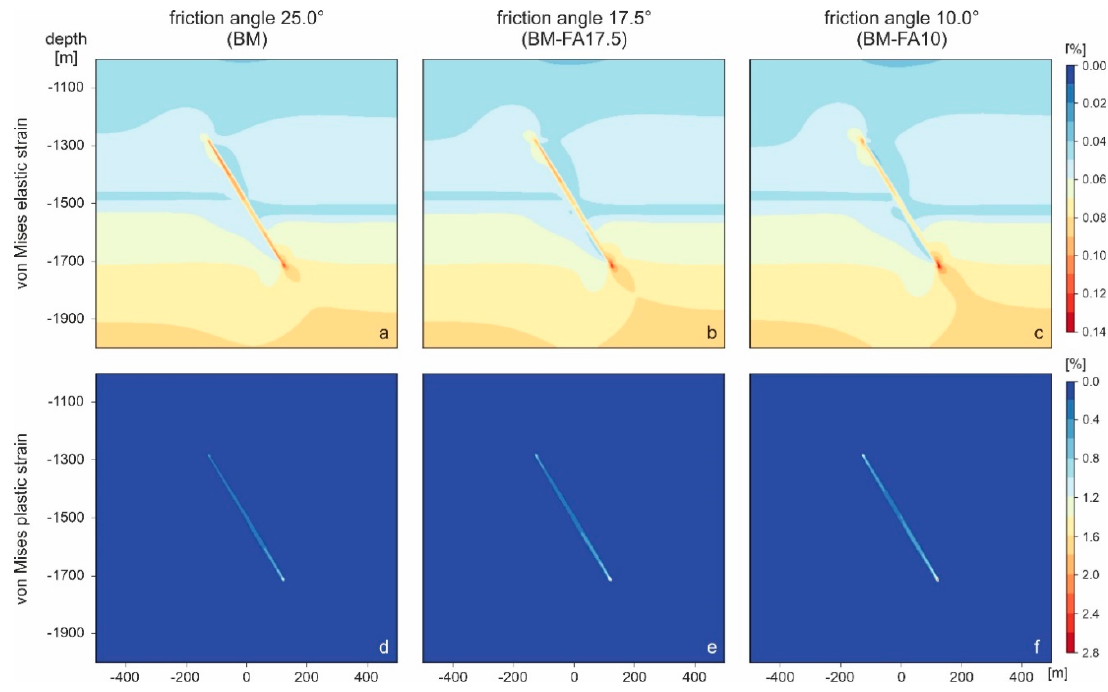
Figure 11. Spatial variations in the van Mises elastic ( a – c ) and plastic ( d – f ) strain after five years of injection for three different friction angles assigned to the fault zone.